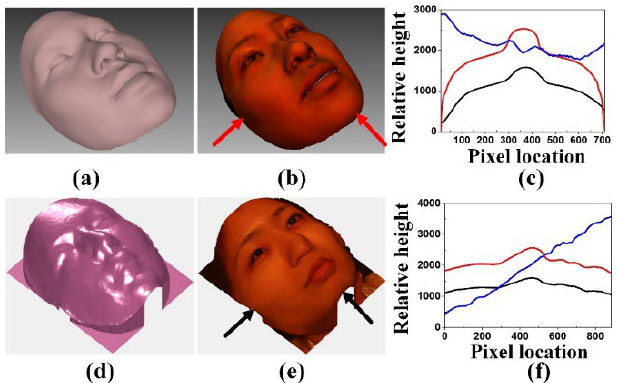
Figure 7. Reconstruction of the Chinese woman wearing no glasses; ( a ) depth profile and ( b ) 3D face recovered from CNN-based 3DMM; ( d ) depth profile and ( e ) 3D face recovered from the proposed method; ( c ) face profile comparison in the horizontal and ( f ) vertical directions from Figure 3c and ( b , e ). Blue, red and black lines indicate profiles from Figure 3c, ( b ) and ( e ), respectively.